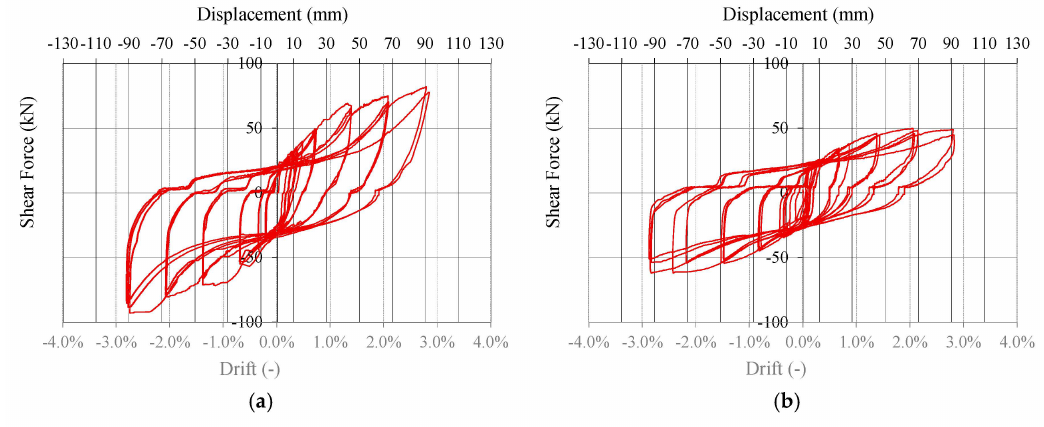
Figure 9. Hysteresis curves: ( a ) Wall A and ( b ) Wall B.